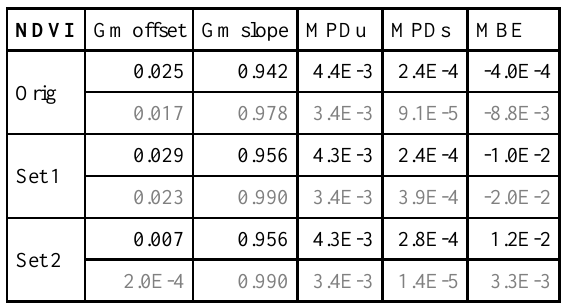
Table 7. Statistical measures for the comparison of PROBA-V (X) and VGT2 (Y) TOC NDVI composites for the original PROBA-V data, Set1 and Set2 PROBA-V data For Blue and Red datasets, the Set1 correction seems to be slightly degrading the relationship between PROBA-V and VGT2: MBE and MPDs are increased, and the GMslope is further from 1 when comparing the new Set1 results with the new Original PROBA-V results. For NIR and SWIR, there is a slight improvement of the similarity after spectral